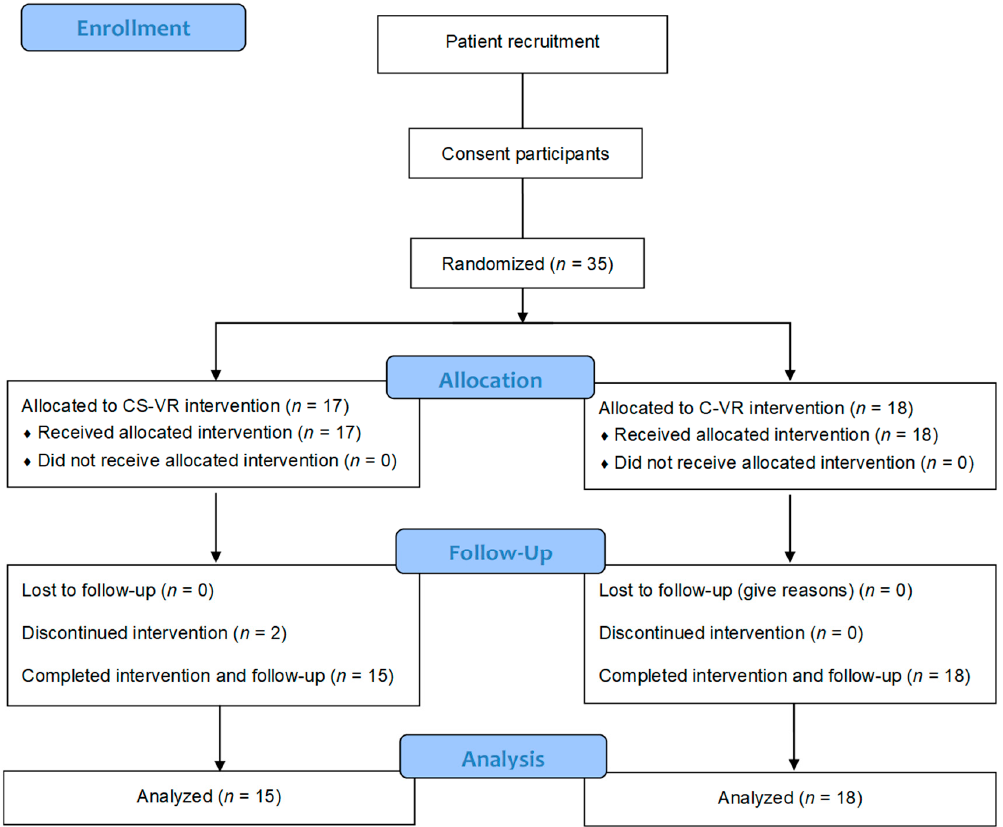
Figure 1. CONSORT flow diagram of methodology and data analysis.